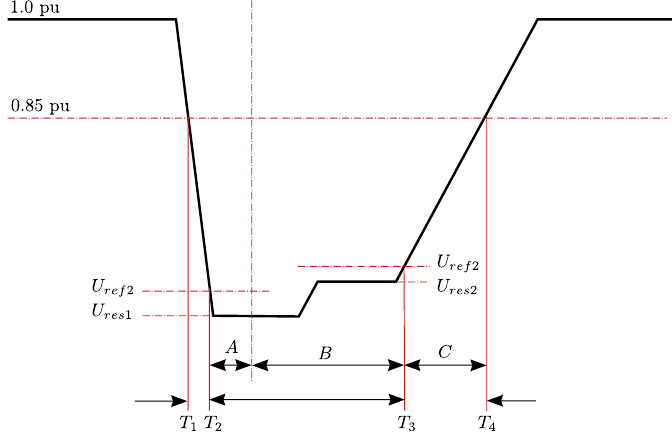
Figure 3. Characterizations of zones during voltage dips according to the PVVC